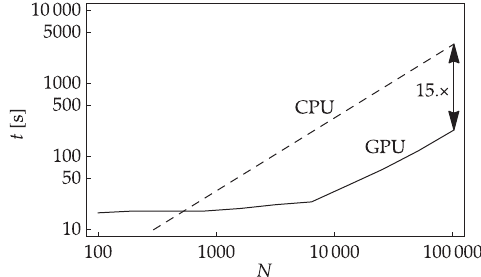
FIG. 17. Time required to track N particles through 100 turns of the RHIC lattice with GPU-accelerated integrators (solid). The CPU time (dashed) is an estimate; see text for FIG. 16. Accumulated spin error as a function of turn number, for multiturn tracking in a RHIC lattice, using different methods of integration. From top to bottom: drift-kick integration with 8 and no tune-fit (tan); the previous standard, a TEAPOT n b ¼ 4 (green); BK/MK with n 4 and no Romberg split with n b ¼ b ¼ 4 (purple). The simulated beam (blue); and BK/MK with n b ¼ had a 95% emittance of 15 π mm mrad.